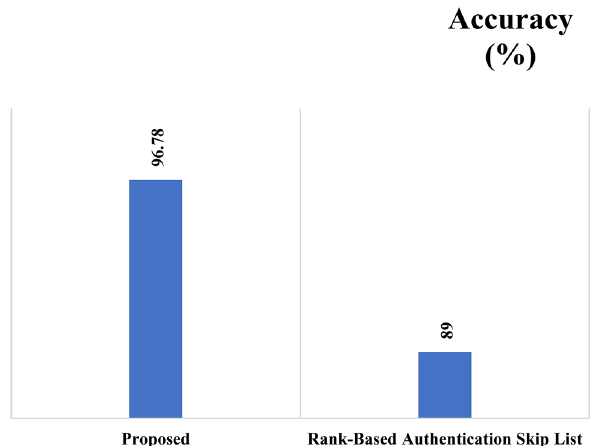
Figure 4. Accuracy analysis.